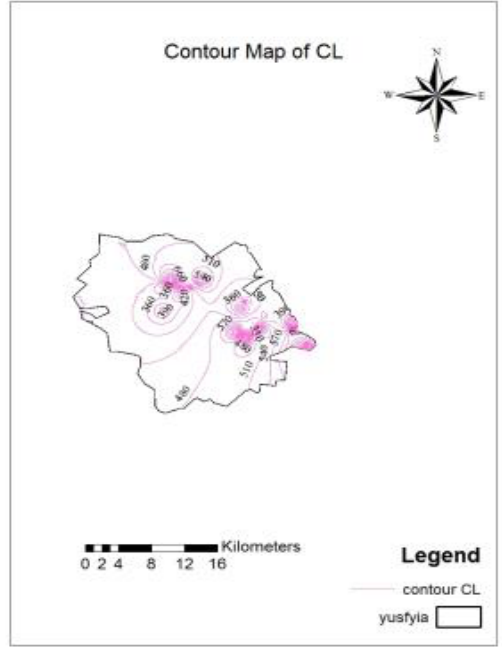
Fig.11: The interpolation and contour line of Cl map in